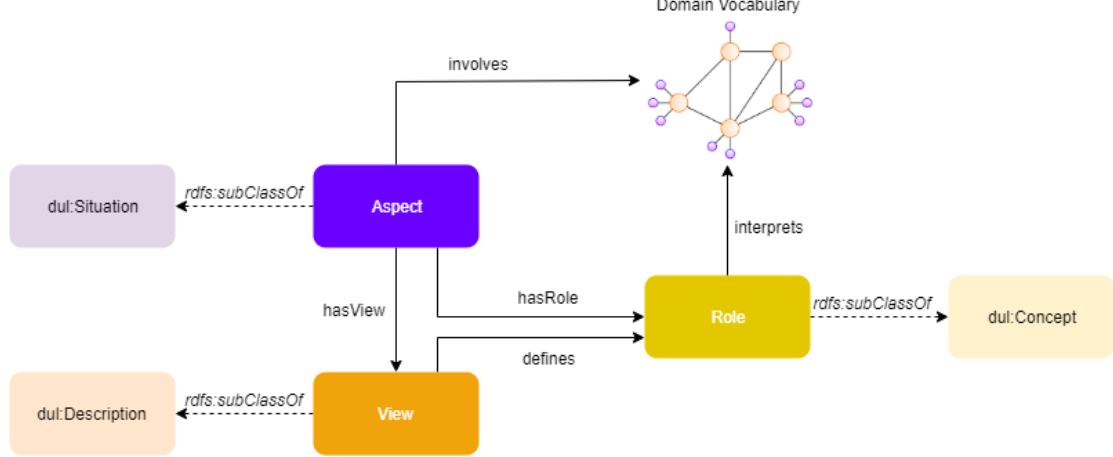
Figure 3. Upper-level pattern for modelling complex